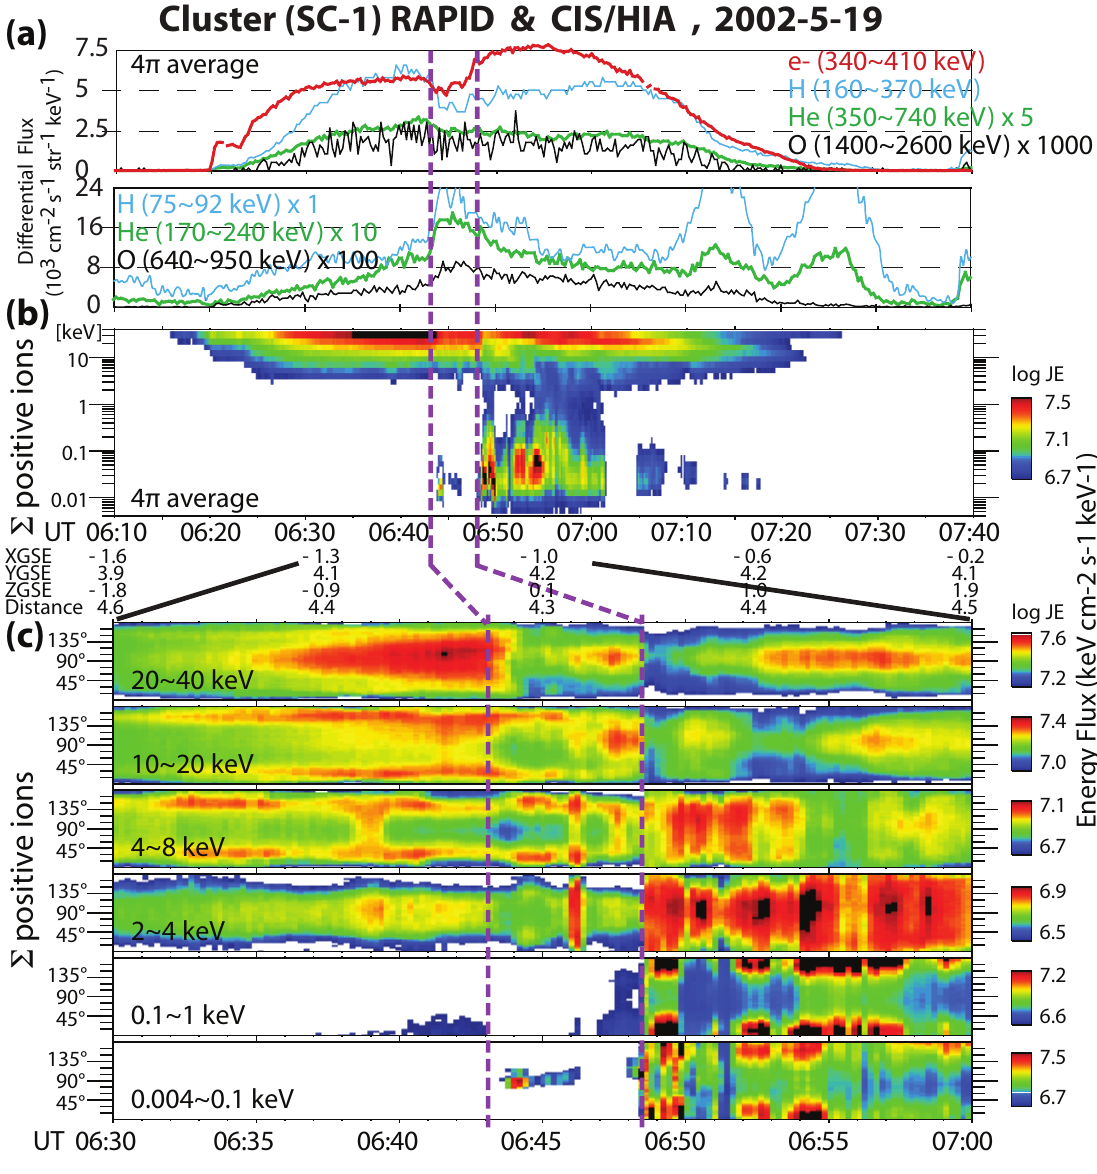
Fig. 1. Cluster particle data from spacecraft-1 during perigee traversal on 19 May 2002 during 06:10 ∼ 07:40UT. (a) Time series plots of 4 π averaged differential fluxes (cm − 2 s − 1 str − 1 keV − 1 ) of energetic particles observed by RAPID. Several energy channels with the same change (sudden decrease or sudden increase) at around 06:43UT are integrated. (b) Energy-time spectrogram of 4 π averaged differential energy flux (keV cm − 2 s − 1 str − 1 keV − 1 ) observed by CIS/HIA. (c) Pitch angle-time spectrograms of differential energy fluxes observed by CIS/HIA at different energy ranges (energy-averaged). For (b) and (c), one pixel corresponds to 12s with 4s sampling (and averaged) and 8s